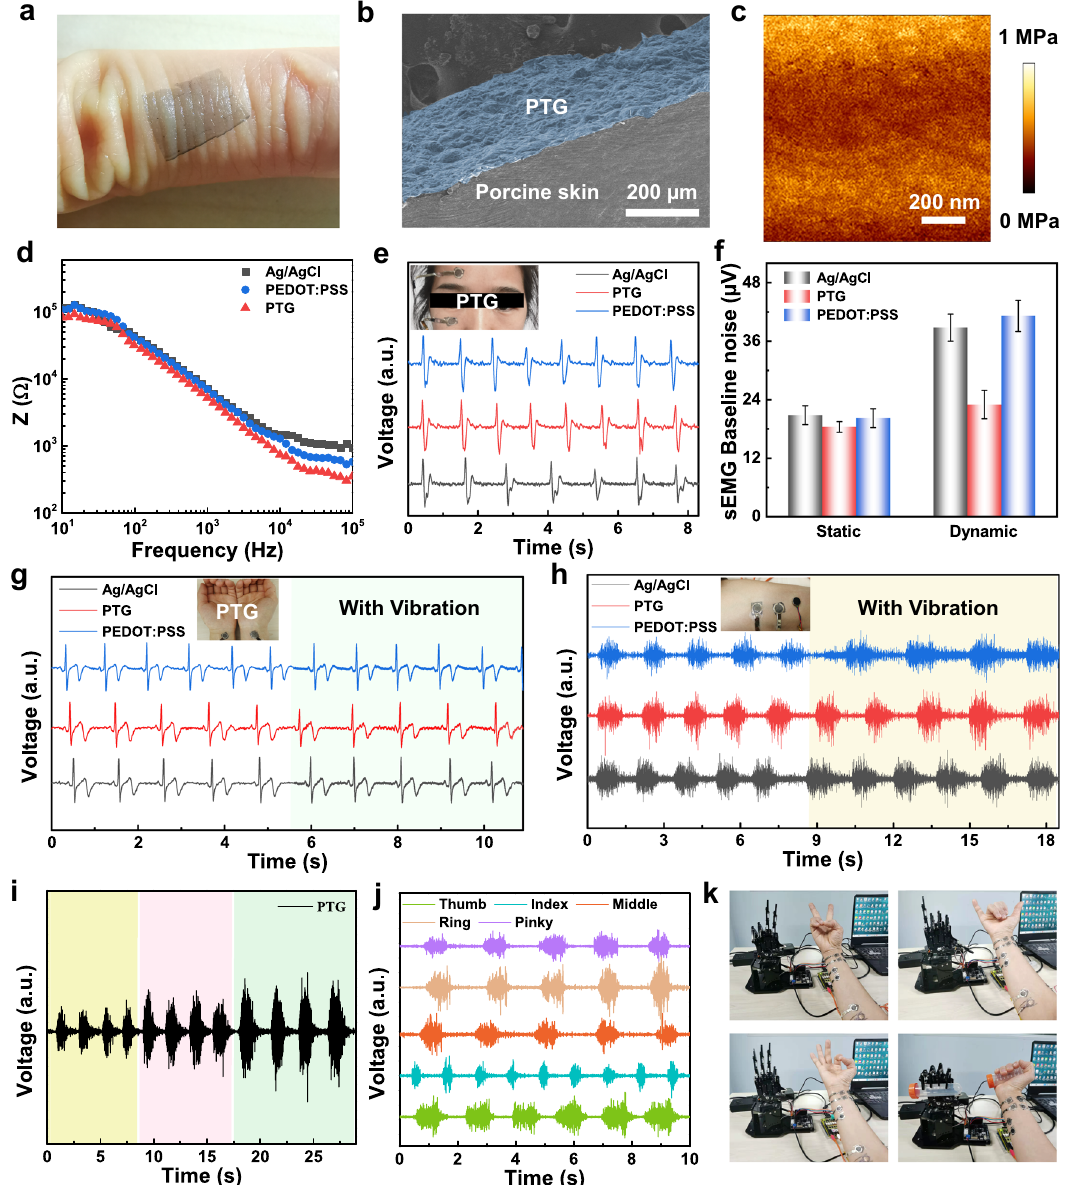
Fig. 5 Electrophysiological signal detection of PTG dry electrodes. a A photograph of PTG conformed on a human ring fi nger. b A SEM image of cross- sectional view of PTG (top) on porcine skin (bottom). c AFM Young ’ s modulus map of PTG. d The impedance analysis of PTG (red), pure PEDOT:PSS (blue) and Ag/AgCl (black) electrodes. e EOG measured by PTG (red), pure PEDOT:PSS (blue) and Ag/AgCl (black) electrodes, showing peaks and valleys corresponding to the eyelid movement. f sEMG baseline noise comparison of the three types of electrodes in static and dynamic status. g ECG measured by PTG (red), pure PEDOT:PSS (blue) and Ag/AgCl (black) electrodes without and with vibration. Characteristic P, Q, R, S, and T waves are clearly identi fi ed. h sEMG measured by PTG (red), pure PEDOT:PSS (blue) and Ag/AgCl (black) electrodes without and with vibration, showing lower- motion artifact detected by PTG. Insets of (e,g., h ) are photos of PTG electrodes for EOG, ECG, sEMG measurements. i sEMG measured by PTG at different griping force, showing that sEMG intensity becomes higher at larger gripping force. j sEMG acquired by PTG from the fi nger (thumb, index, middle, ring, and little fi ngers) motion. k Driving the robotic hand to show various gestures (victory, Arabic numerals of six and three, and holding a centrifuge tube) based on multi-channel sEMG signals extracted by PTG electrodes. Five PTG electrode pairs were adhered on designated locations for acquiring sEMG signals of thumb, index, middle, ring and little fi ngers, and remotely driving the movement of robotic hand. (cid:1) SEM imaging of PTG on porcine skin (Fig. 5b, Supplementary where E represents Young ’ s modulus, h represents thickness, υ Fig. 11). The interfacial impedance analysis between electrodes represents Poisson ratio. The ultra-thin nature and low Young ’ s and skin was conducted on the human arm with electrodes placed modulus of PTG lead to a similar bending stiffness with that of on the surface of it (Fig. 5d). PTG showed comparable interfacial skin, indicating conformal contact with wrinkled skin (see Dis- impedance with PEDOT:PSS dry electrodes and commercial Ag/ cussion in Supplementary information) 13,45 . Transferred onto a AgCl gel electrodes, and at 100 Hz, the impedance (~32 k Ω ) is human ring fi nger full of wrinkles, PTG indeed exhibited intimate lower than PEDOT:PSS (~42 k Ω ) and the Ag/AgCl (~45 k Ω ). contact on it (Fig. 5a). The conformability is also con fi rmed by NATURE COMMUNICATIONS| (2021) 12:4880